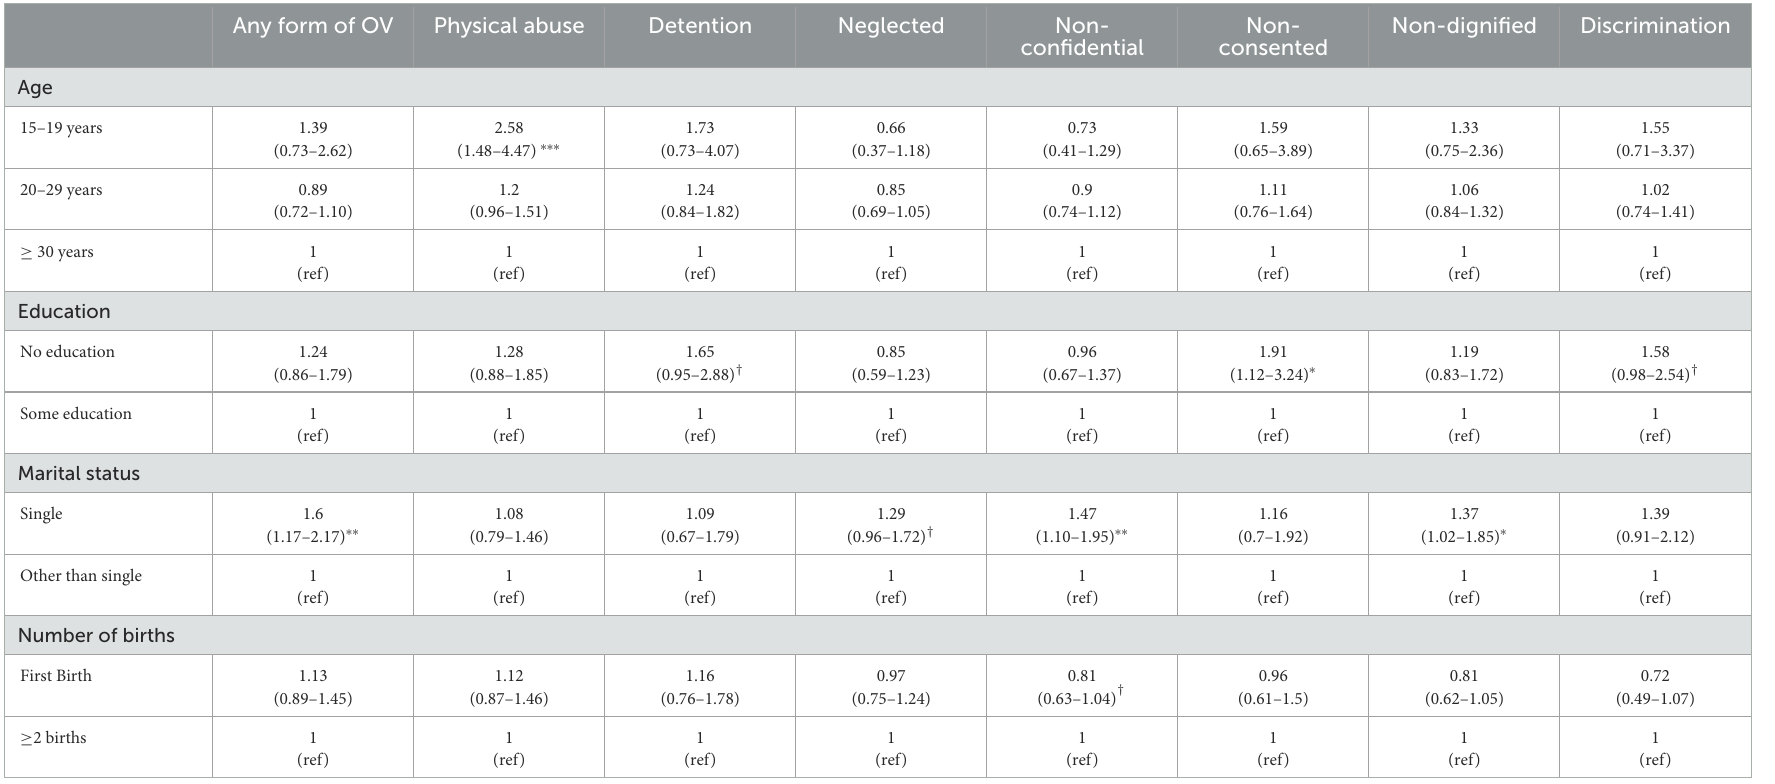
TABLE 4 Multivariable Logistic regression models of the factors associated with different forms of obstetric